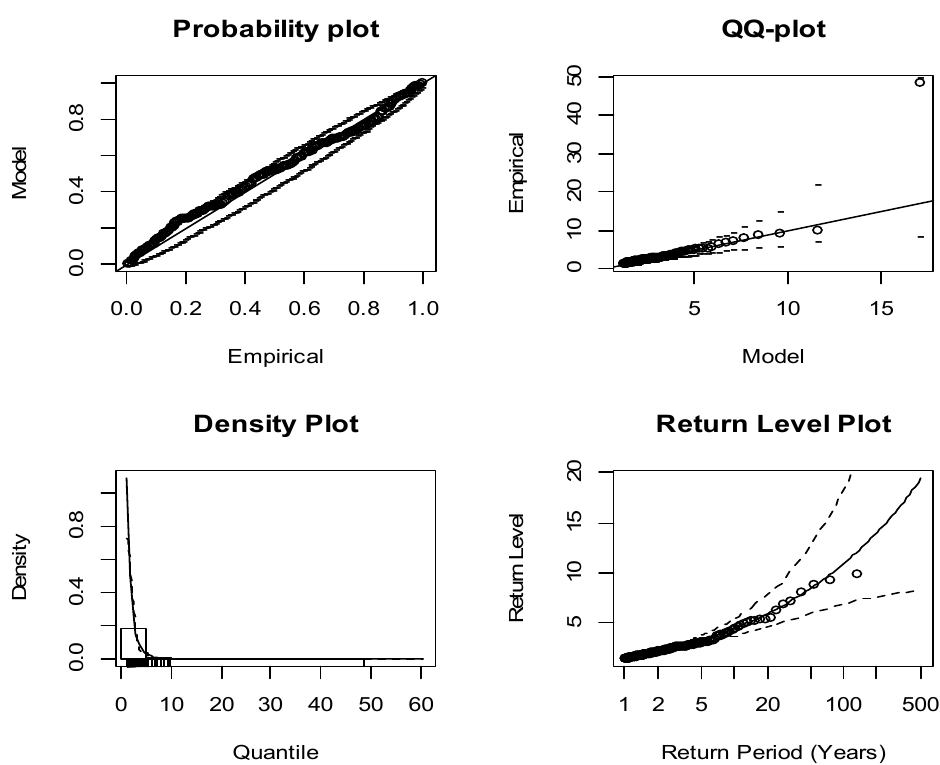
Figure 6. Diagnosis plot of losses.